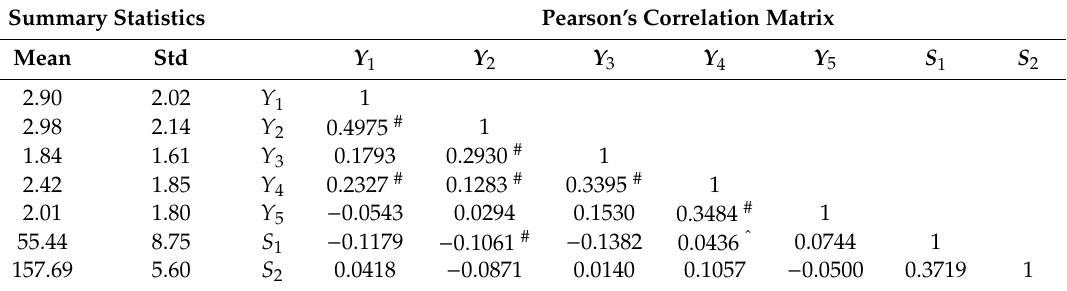
Table 13. Statistical information of the perturbed data using the CGADP method. Summary Statistics